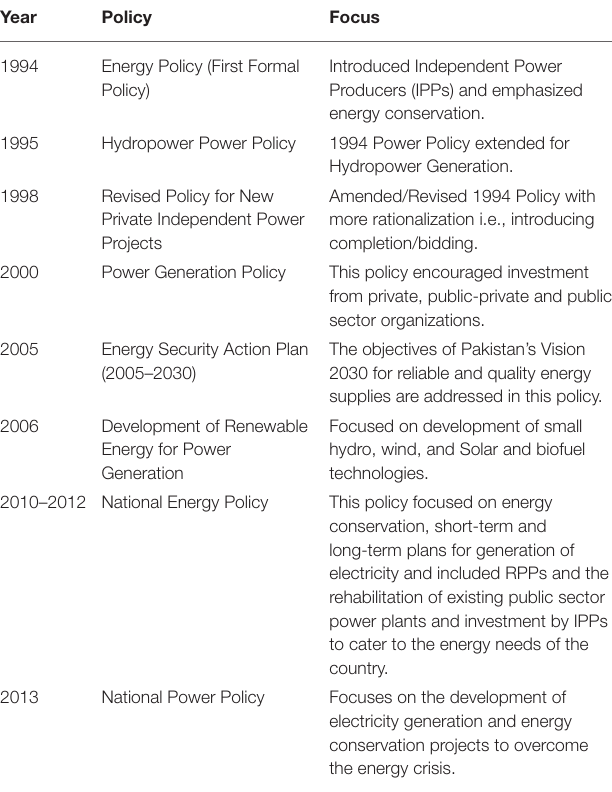
TABLE 2 | National energy policies of Pakistan with their major focus (Abbas, 2015; Valasai et al.,